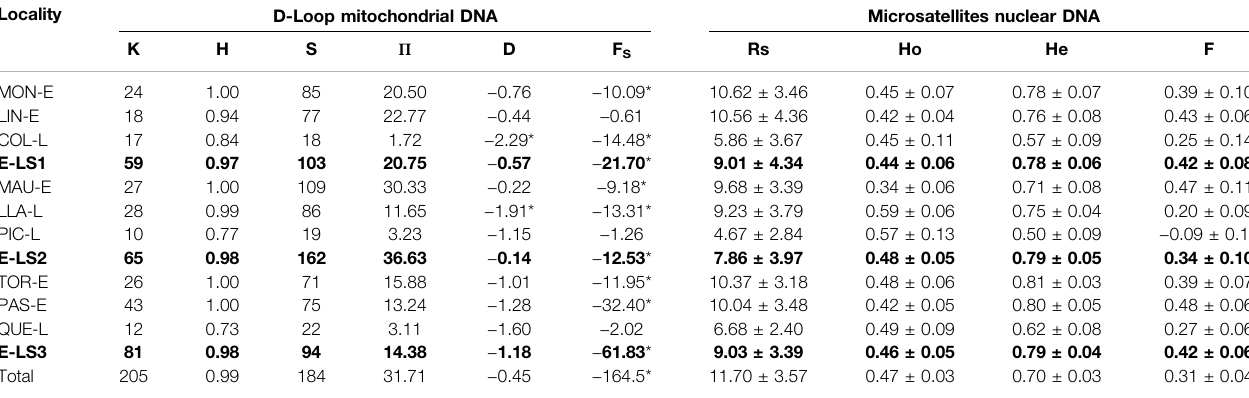
TABLE 2 | Diversity indices and neutrality tests in Galaxias maculatus populations in the different E-LS across the species distribution in western Patagonia. D-Loop mitochondrial DNA Microsatellites nuclear DNALocality